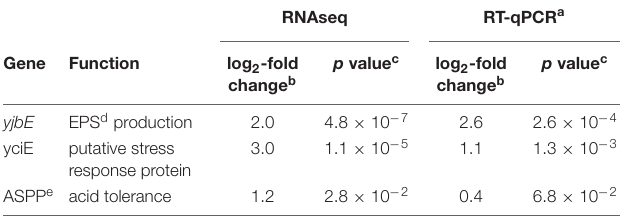
a Reverse transcriptase quantitative PCR. b Averagelog 2 -foldchangefromthreebiologicalreplicates,valuesarelevelsinE40V compared to E40. c Benjamini-Hochberg adjusted (Benjamini and Hochberg, 1995). Calculated using student’s t-test. d Extracellular polymeric substance.